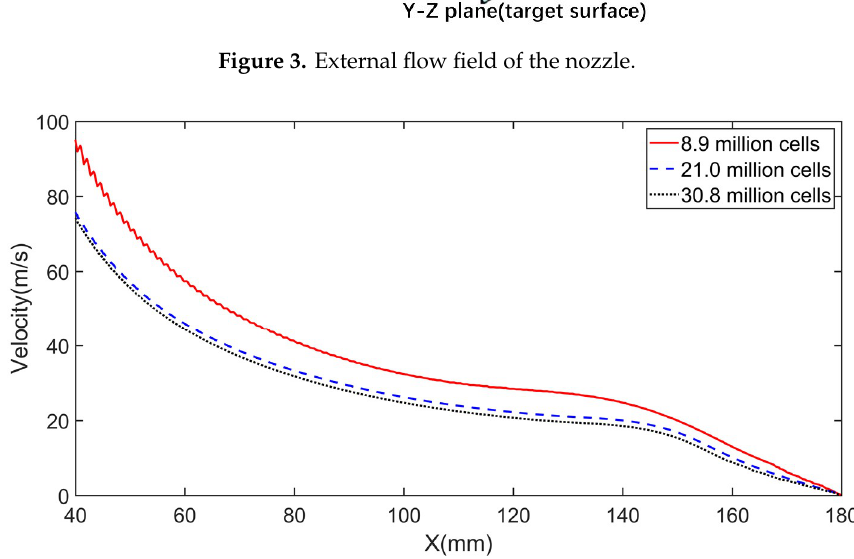
Figure 4. Gas velocity along the x -axis with different computational cells in the whole domain.